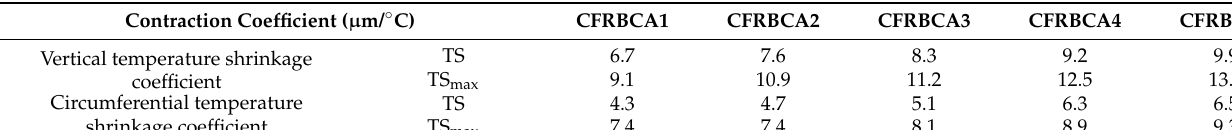
Figure 2. Freeze-thaw cycle test: ( a ) and ( b ).